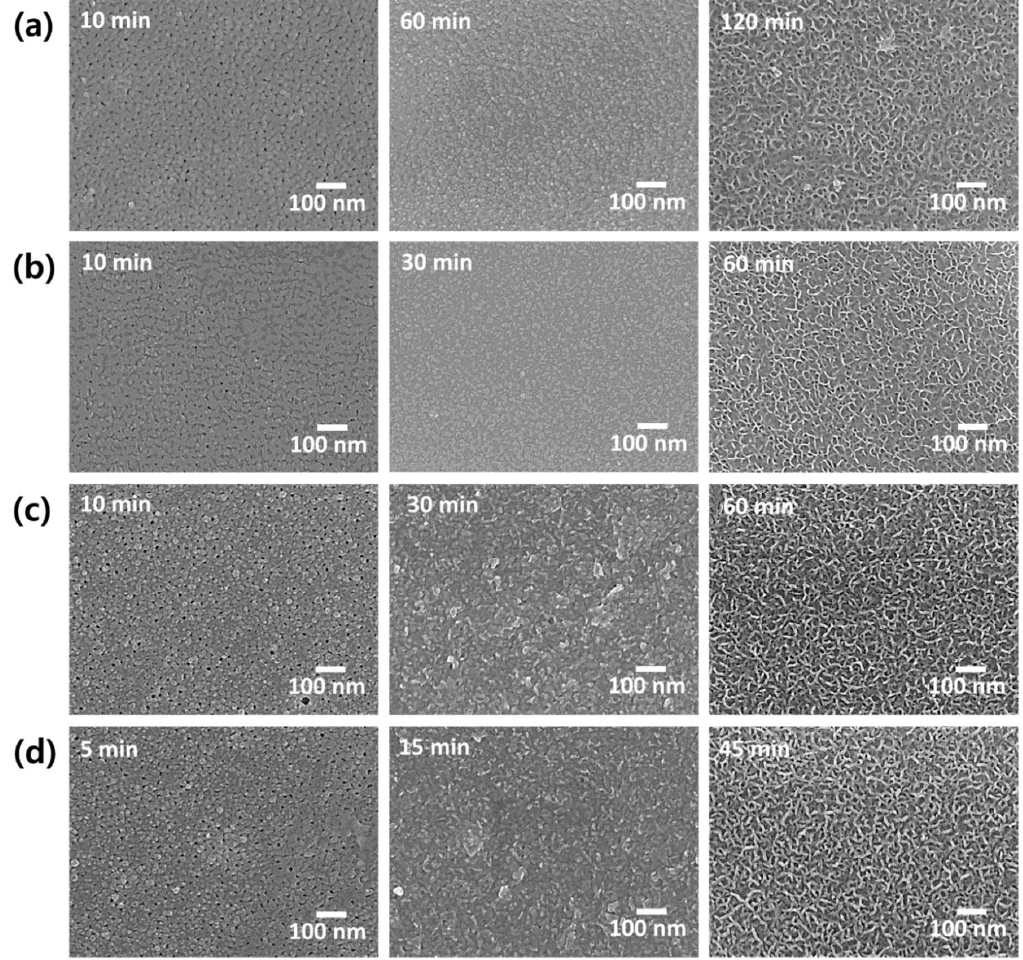
Figure 5. Surface SEM images of anodized aluminum alloy with sealing in mixed solution ( a ) MSS1, ( b ) MSS2, ( c ) MSS3 and ( d ) MSS4 with respect to various treatment times.